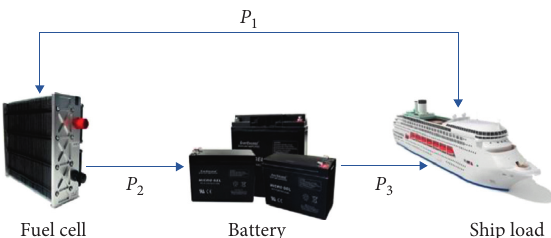
Figure 2: FC/battery/ship’s load topology.